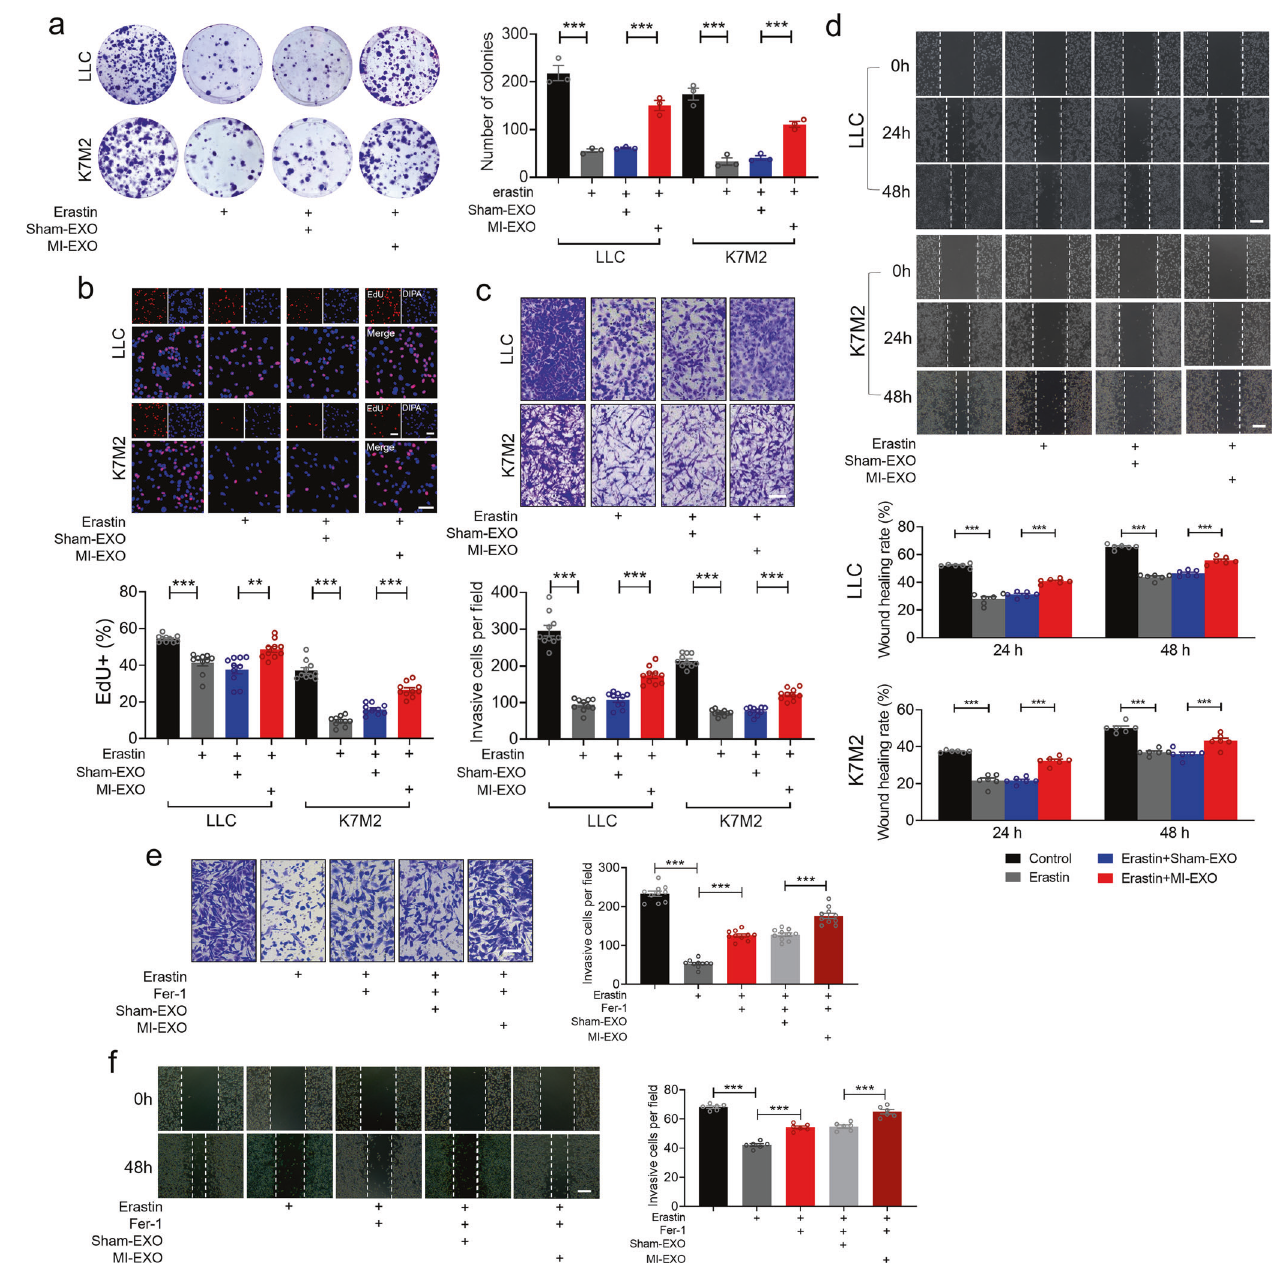
Fig. 4 MI-EXO promotes tumor cell proliferation, invasion, and migration through its antiferroptotic effects. a – d LLC and K7M2 cells were co- cultured with sham/MI exosomes (1 μ g/mL) in the presence of erastin (20 μ M for K7M2; 5 μ M for LLC) for 24 h. a Representative images and quantitative results of cancer cell colonies ( N = 3 independent experiments); b Cell proliferation was measured using an EdU staining kit (Bar: 40 μ m) ( N = 10 from 3 independent experiments); c Cell invasion was detected by transwell assay (Bar: 100 μ m) ( N = 10 from 3 independent experiments); d Migration ability was determined by wound-healing assay at 0, 24, and 48 h, respectively (Bar: 100 μ m) ( N = 6 from 3 independent experiments); e , f LLC cells were co-cultured with sham/MI exosomes (1 μ g/mL) in the presence of erastin and Fer-1 (2 μ M) for 24 h. e Cell invasion was detected by transwell assay (Bar: 100 μ m) ( N = 10 from 3 independent experiments); f Migration ability was detected by wound-healing assay at 0 h and 48 h (Bar: 100 μ m) ( N = 6 from 3 independent experiments). Data are expressed as mean ± SEM. ** P < 0.01; *** P < 0.001 levels. Notably, the level of pre-miR-22 was markedly upregulated approximately 18.3-fold higher in cardiac tissue than in tumor in cardiac tissue but not in tumor tissue from MI animals (Fig. 5h). tissue of sham-operated mice. With MI, however, miR-22-3p While these results support that the exosomes secreted from MI expression was signi fi cantly elevated in tumor tissue as compared heart contributes to the elevation of miR-22-3p in tumor tissue, it with sham-controls (Fig. 5g). To clarify whether the increase of miR- was yet to be determined if miR-22-3p mediates the MI-EXO- 22-3p level could be ascribed to its release from cardiomyocytes induced increase in resistance of cancer cells to ferroptosis. via exosomes or due to its production from tumor cells per se after To clarify this issue, we carried out in vitro experiments to explore MI, we measured the changes of precursor miR-22 (pre-miR-22)